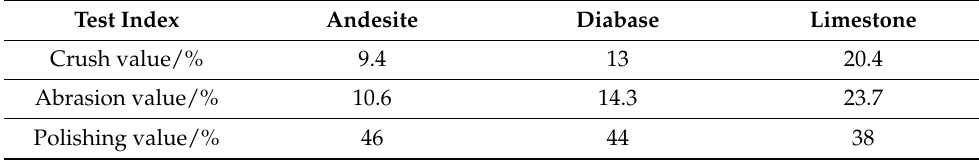
Table 2. Coarse aggregate technical index test results.